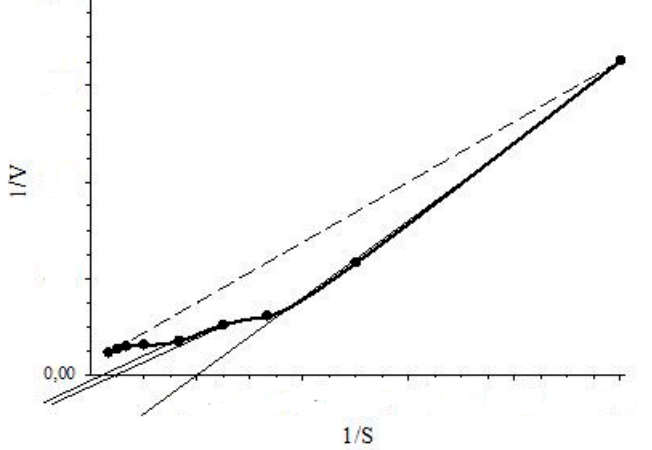
Figure 4. Intersection with the 1/ S axis for the tangent to the concave curve (positive kinetic cooperativity by substrate, the Hill kinetics): dotted line is 1/V-1/S plot for the Michaelis-Menten dependency, the solid thick curve is the 1/V-1/S plot for the Hill dependency (positive cooperativity).